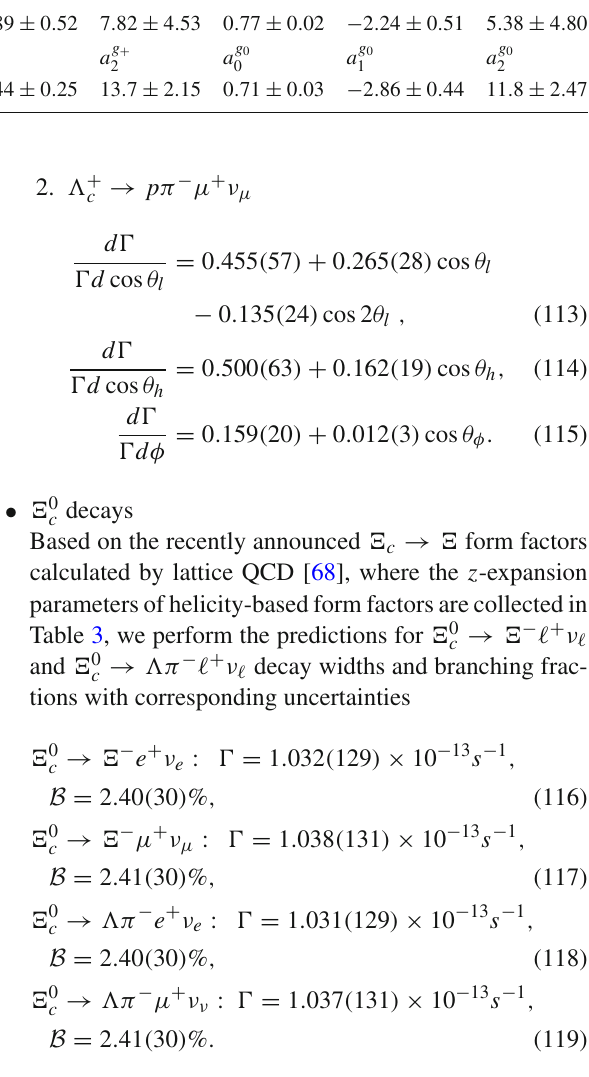
Table 2 The (cid:4) c → (cid:4) form factors calculated on the lattice [74] a f ⊥ a f ⊥ 0